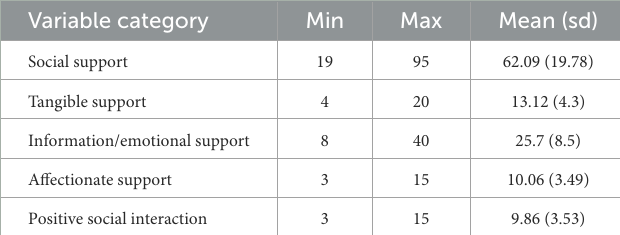
TABLE 3 Perceived social support and its sub-scale in participants in study. Variable